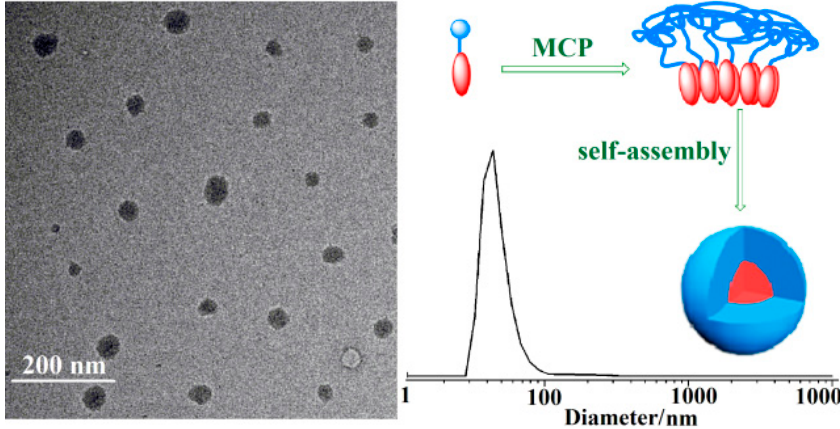
Figure 3. ( a ) TEM image and the schematic illustration of double-stranded P1 . Figure 3. TEM image and the schematic illustration of double-stranded P1